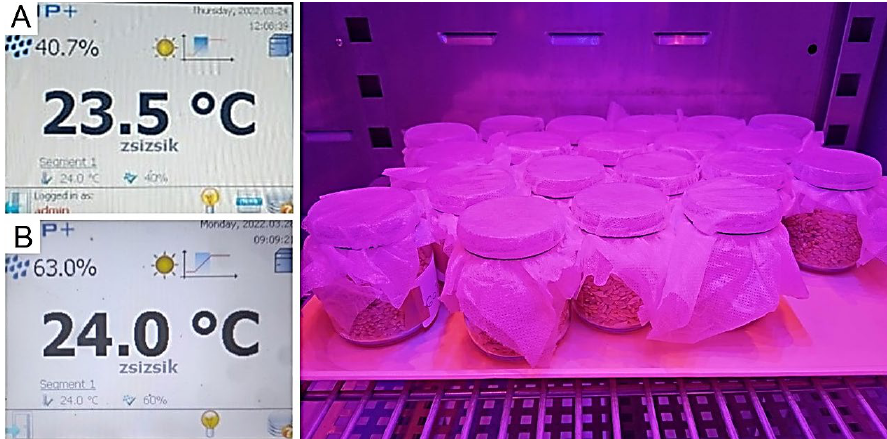
Figure 1. Experimental glass jars in the climate chamber after heat transmission under two abiotic parameter settings: 26 ± 3 °C with ( A ) 40 ± 5% rh as well as ( B ) 60 ± 5% rh.